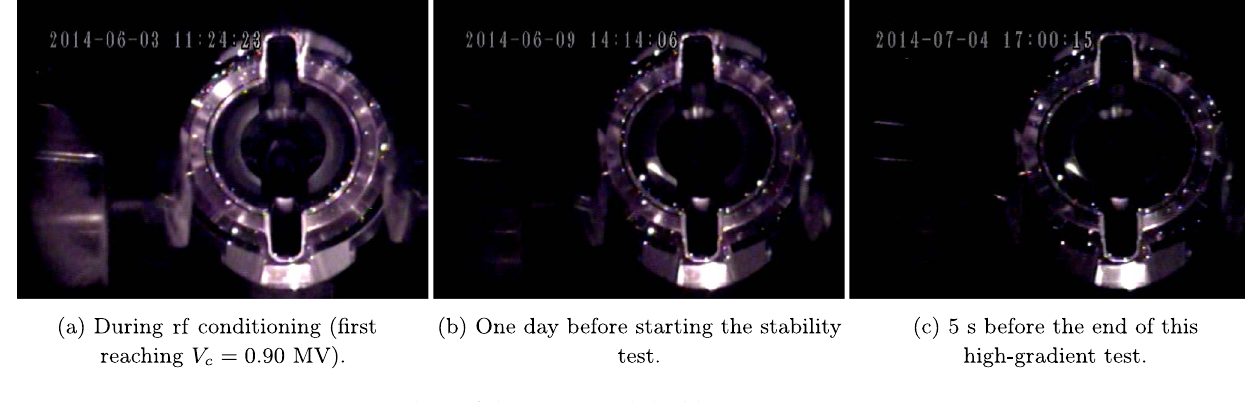
FIG. 10. Snapshots of the FEP recorded with TV camera 3 at V c ¼ 0 . 90 MV.